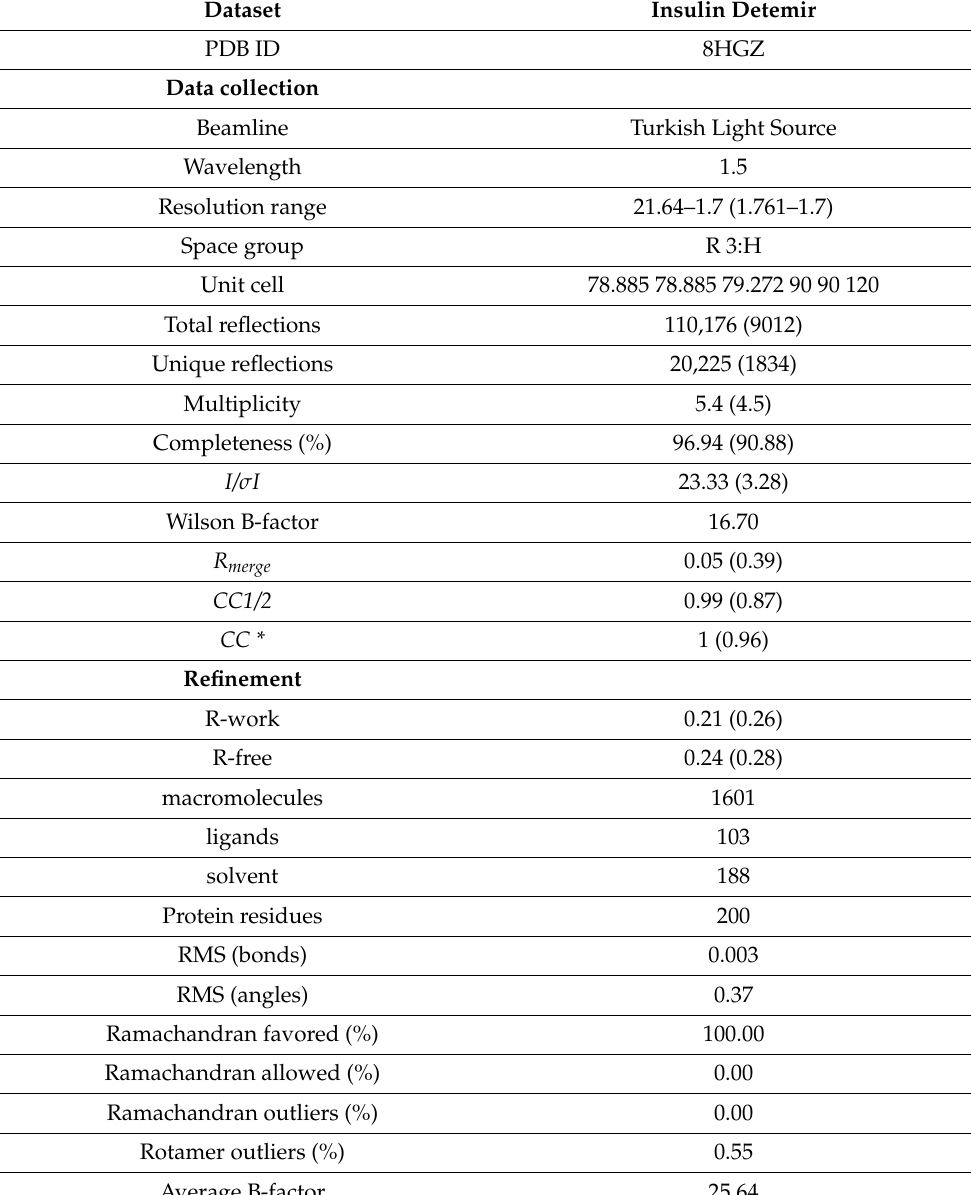
Table 1. Data collection and refinement